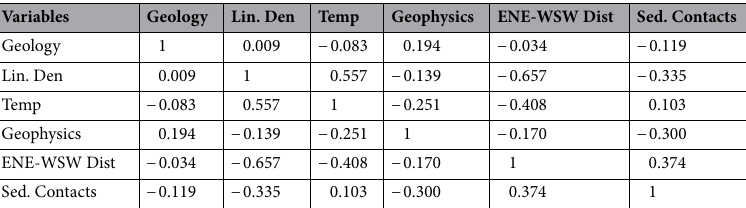
Table 1. Statistical correlation among exploratory